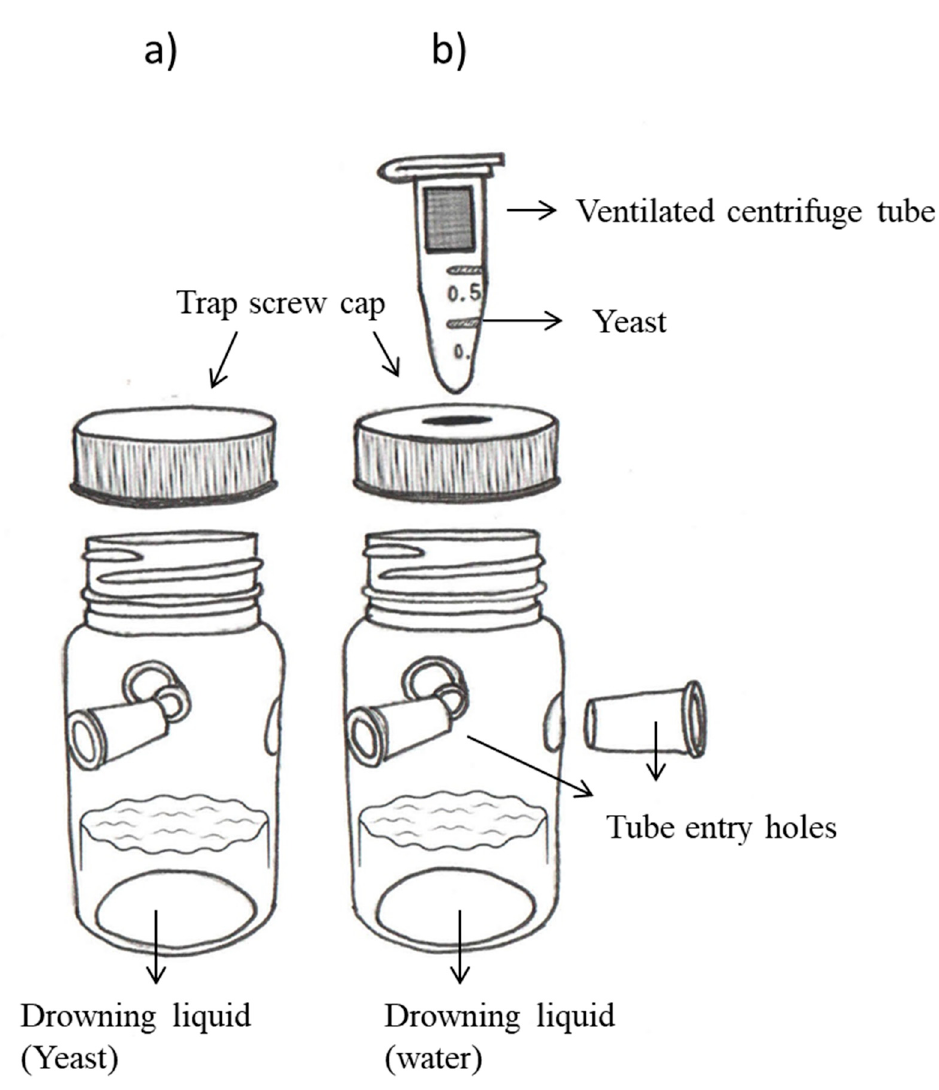
Figure 1. Trap models used for laboratory experiments comprising a 120 mL transparent plastic bottle with ( a ) a conventional white screw cap and ( b ) a white perforated screw cap in which a ventilated centrifuge tube containing yeast samples could be